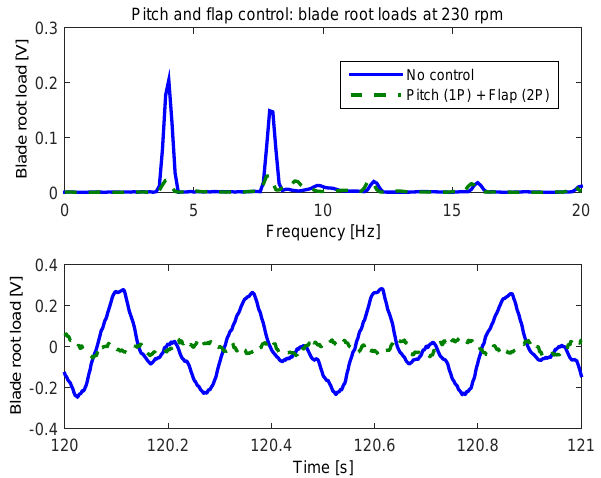
Figure 18. Load reductions achieved by optimised controller (pre- flutter).